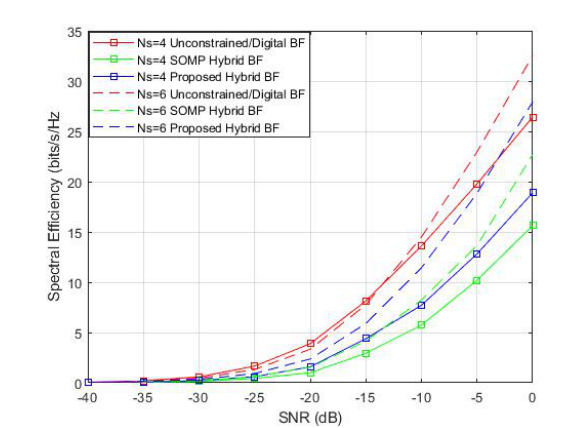
Fig. 12. Spectral efficiency for UPA